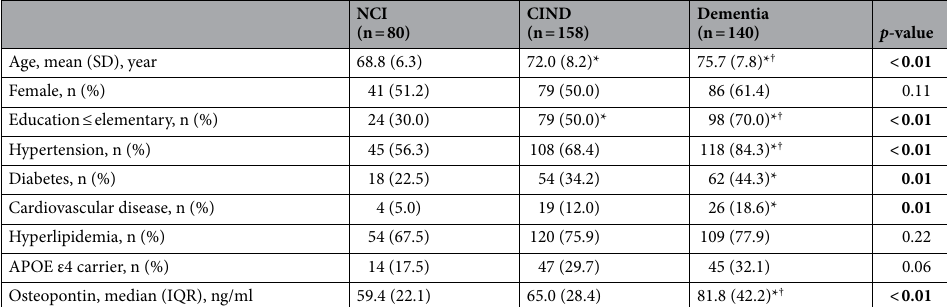
Disease and Related Disorders Association (NINCDS-ADRDA) criteria 44 , while vascular dementia (VaD) being diagnosed using the National Institute of Neurological Disorders and Stroke-Association Internationale pour la Recherché et l’ Enseignement en Neuroscience (NINDS-AIRENS) criteria 45 . Assessments of other risk factors. Risk factors such as hypertension, hyperlipidemia, diabetes and cardiovas- cular diseases were ascertained from clinical interview and medical records and classified as present or absent. Hypertension was defined as systolic blood pressure ≥ 140 mmHg and/or diastolic blood pressure ≥ 90 mmHg or use of antihypertensive medications. Diabetes mellitus was defined as glycated hemoglobin ≥ 6.5%, or on medi- cation. Hyperlipidemia was defined as total cholesterol levels ≥ 4.14 mM, or on medication. Cardiovascular dis- ease was classified as a previous history of atrial fibrillation, congestive heart failure and myocardial infarction.